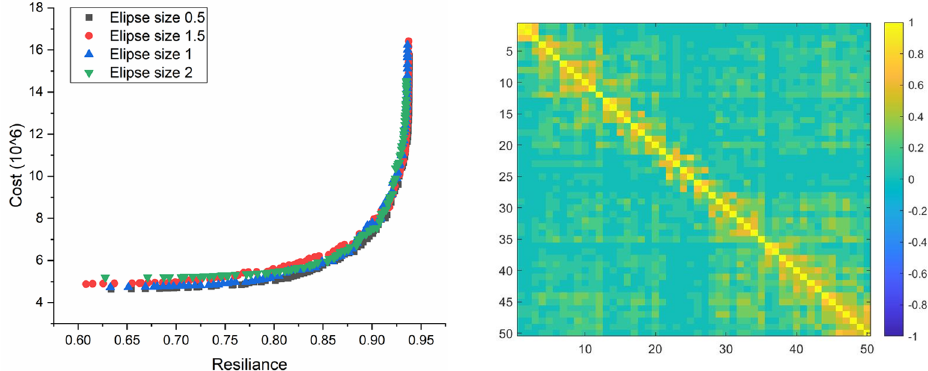
Figure 4. Graphical representation of large network introduced by Alperovits and Shamir.